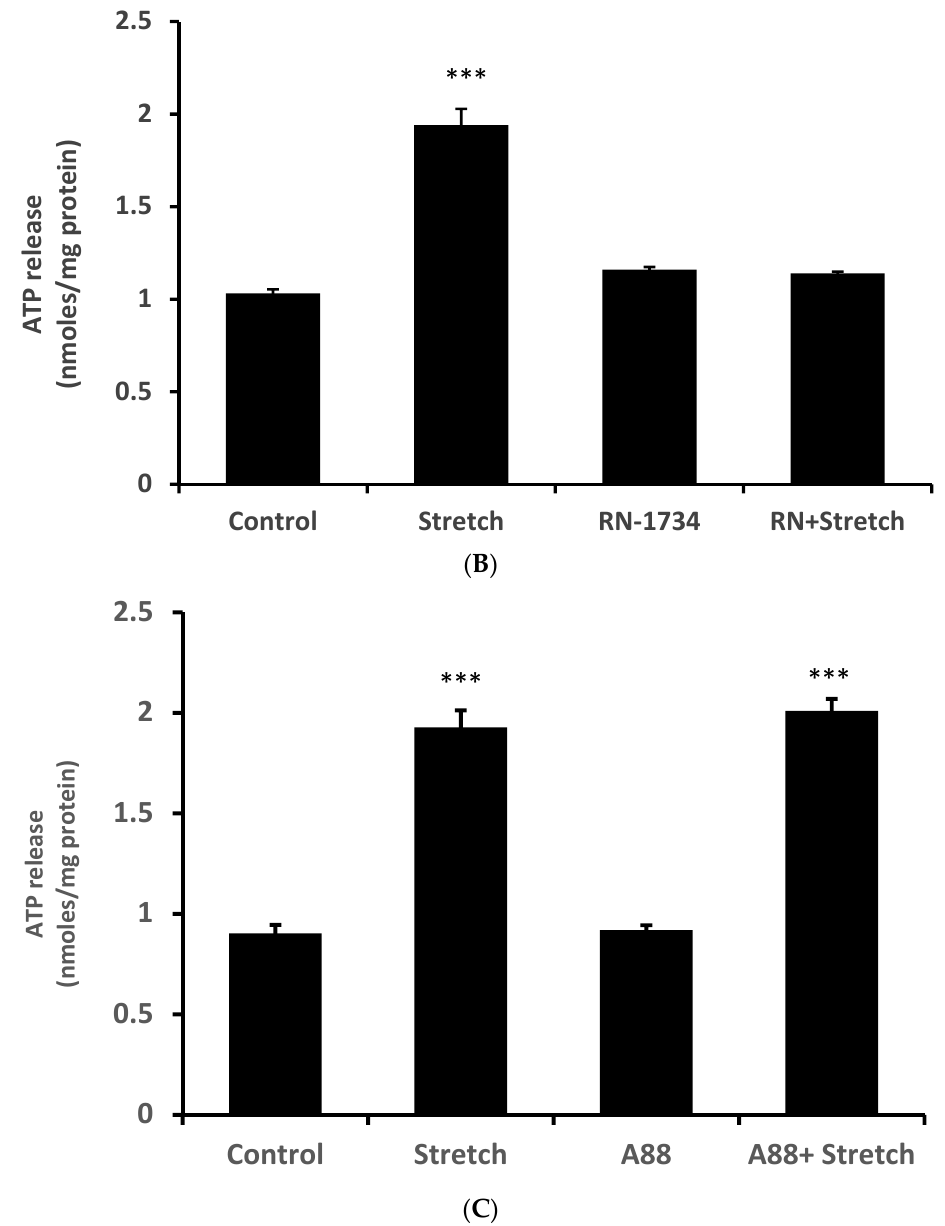
Figure 3. The ATP release response to cyclic stretch was inhibited by the selective TRPV4 antagonists HC 067047 and RN-1734 but not by the TRPV1 antagonist A889425. The amount of ATP in the bathing medium was measured after subjecting monolayers of cultured NPE cells to 10% cyclic stretch (0.5 Hz) for 2 min in the presence of either HC 067047 (10 µM) ( A ) or RN-1734 (10 µM) ( B ) or A889425 (1 µM) ( C ) added 20 min beforehand. The data are the mean ± SE of results from six independent experiments. ** ( p < 0.01) and *** ( p < 0.001) indicate significant differences from control and ### ( p < 0.001) indicates significant differences from a stretch stimulus.